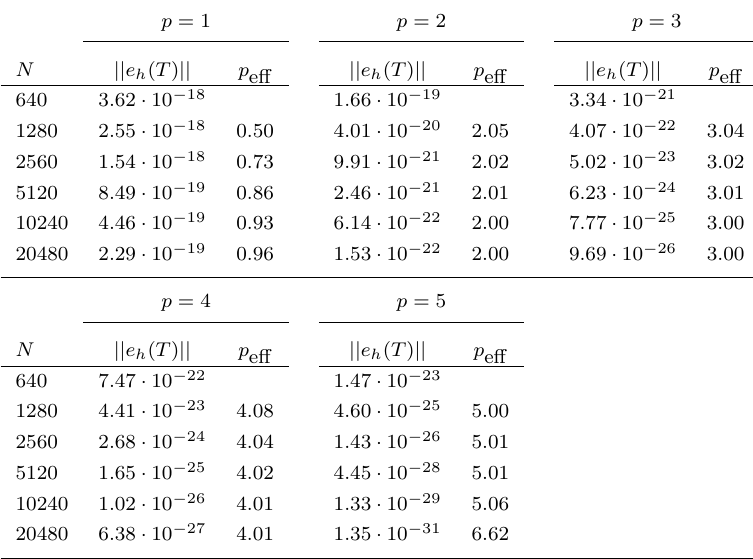
Table 1. Numerical results of method of order p = 1 , 2 , 3 , 4 , 5 for problem (4.1), T = 1, with constant